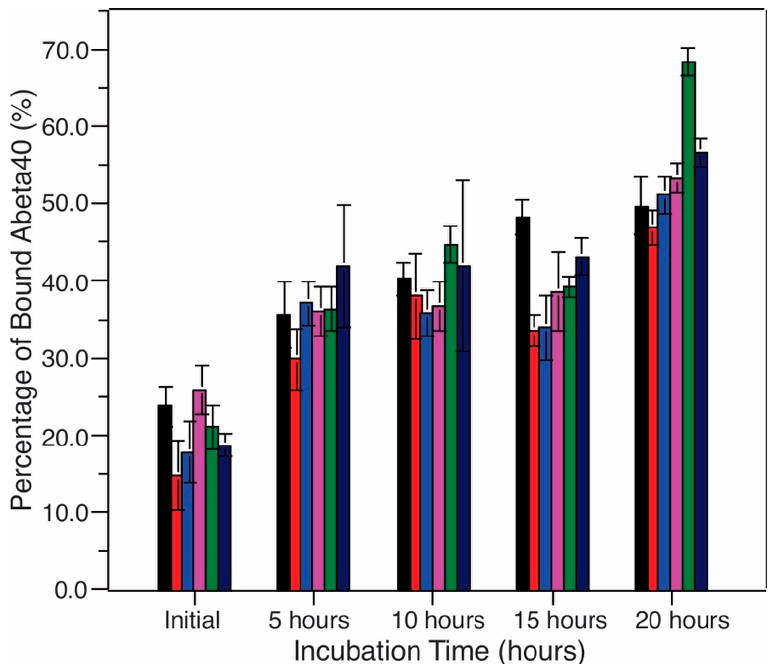
Figure 8. Quantitative analysis of membrane-bound A β 40 as a function of incubation time within the first 20 h. Different color-codings were utilized for different model membranes: black, PC; red, PC/chol; blue, PC/S; purple, PC/S/chol; green, PC/S/E; dark navy, PC/S/E/chol. Error bars represent the s.t.d. from three independent measurements.